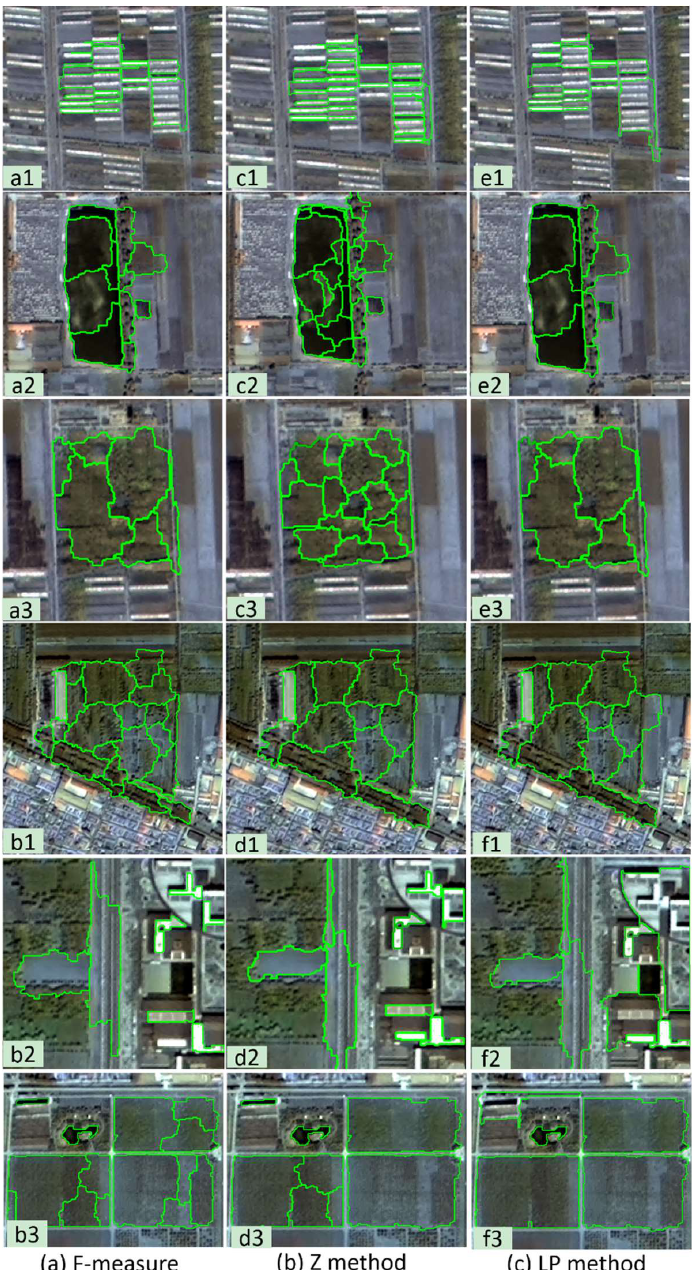
Figure 10. Subsets of the segmentation results in Figure 9, which are the F-measure, Z, and LP results from left to right.